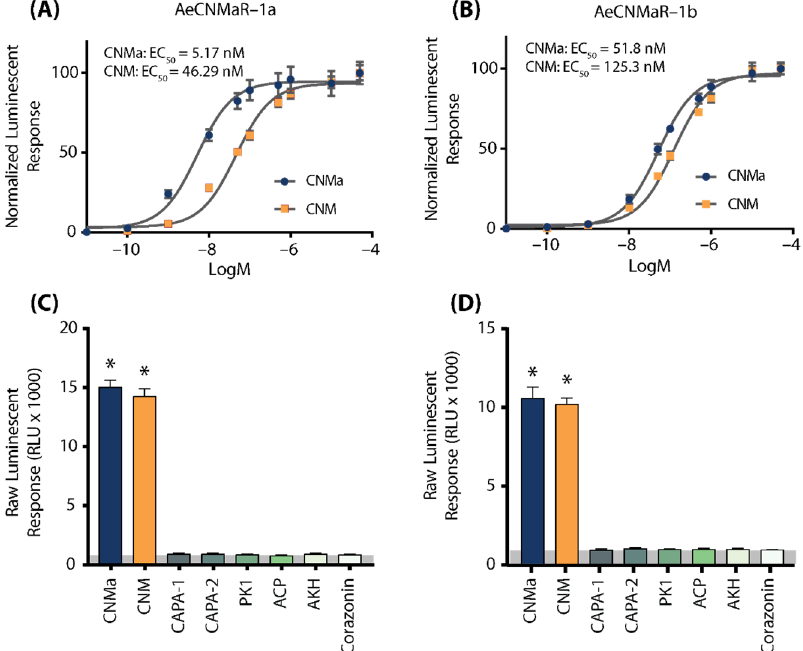
Figure 2. Luminescent response of CHO-K1 aeq cells expressing the Ae. aegypti CNMa receptors, AeCNMaR-1a ( A , C ) and AeCNMaR-1b ( B , D ). Transient expression of receptors in cells was used to examine functional activation by amidated and non-amidated CNM peptides. Both ligands were able to activate both receptors, with the AeCNMaR-1a receptor displaying higher sensitivity. Lumines- cence at every dose examined was normalized to the responses obtained following 50 µ M AeCNMa application ( A ). Raw luminescent responses were also examined following treatment with various Ae. aegypti peptides tested at 1 µ M ( C , D ). Only AeCNMa and AeCNM peptides were able to elicit a response significantly different from background control (BSA media alone in grey shaded area), denoted by an asterisk, as determined by a one-way ANOVA and Dunnett’s multiple comparison post-hoc